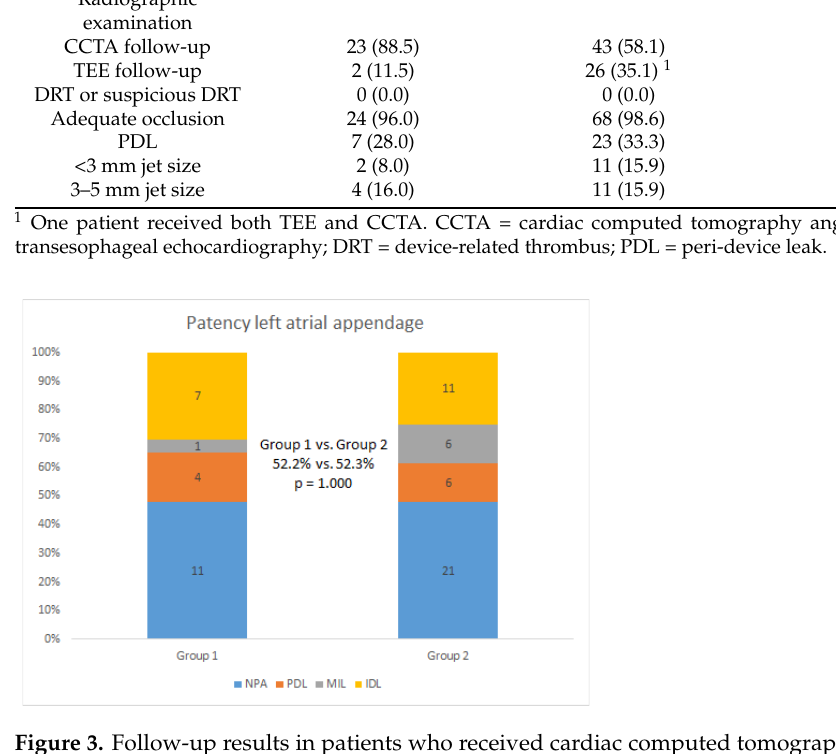
Figure 4. Cardiac function pre ‐ and post ‐ ethanol infusion. Panel ( A ) Changes in the left atrial diam ‐ eter; Panel ( B ) Changes in the right atrial diameter; Panel ( C ) Changes in the left ventricular ejection fraction. Variables were compared using the paired t ‐ test. 4. Discussion In this study, the clinical influence of EI ‐ VOM on LAAO was reported during im ‐ plantation and after 60 days of follow ‐ up. The following was found: (1) EI ‐ VOM did not make the LAAO procedure more difficult because all intra ‐ procedural LAAO parameters